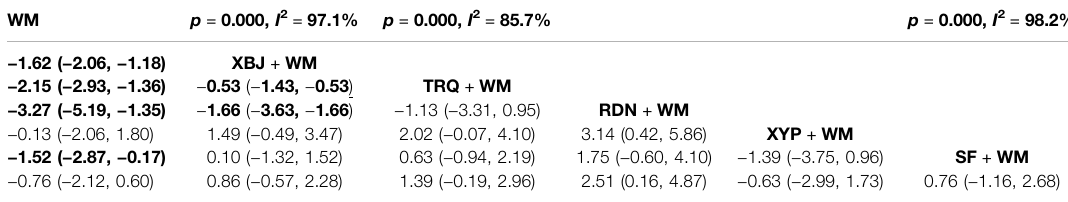
TABLE 4 | SMDs with 95% CIs of the level of CRP.